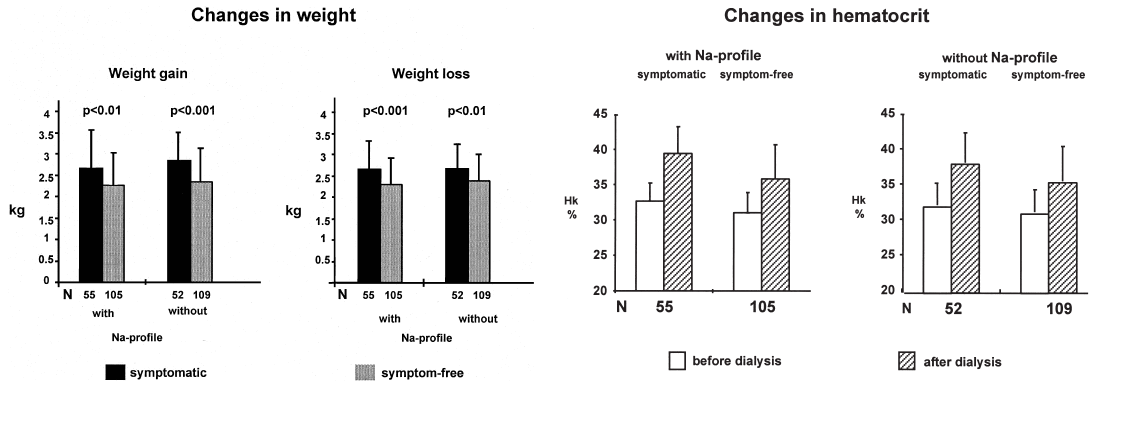
The increase in haematocrit during dialysis (difference be- tween the pairs of columns) was significantly higher during symptomatic versus symptom-free dialyses (with Na-profile p <0.001, without Na-profile p <0.001, Student’s